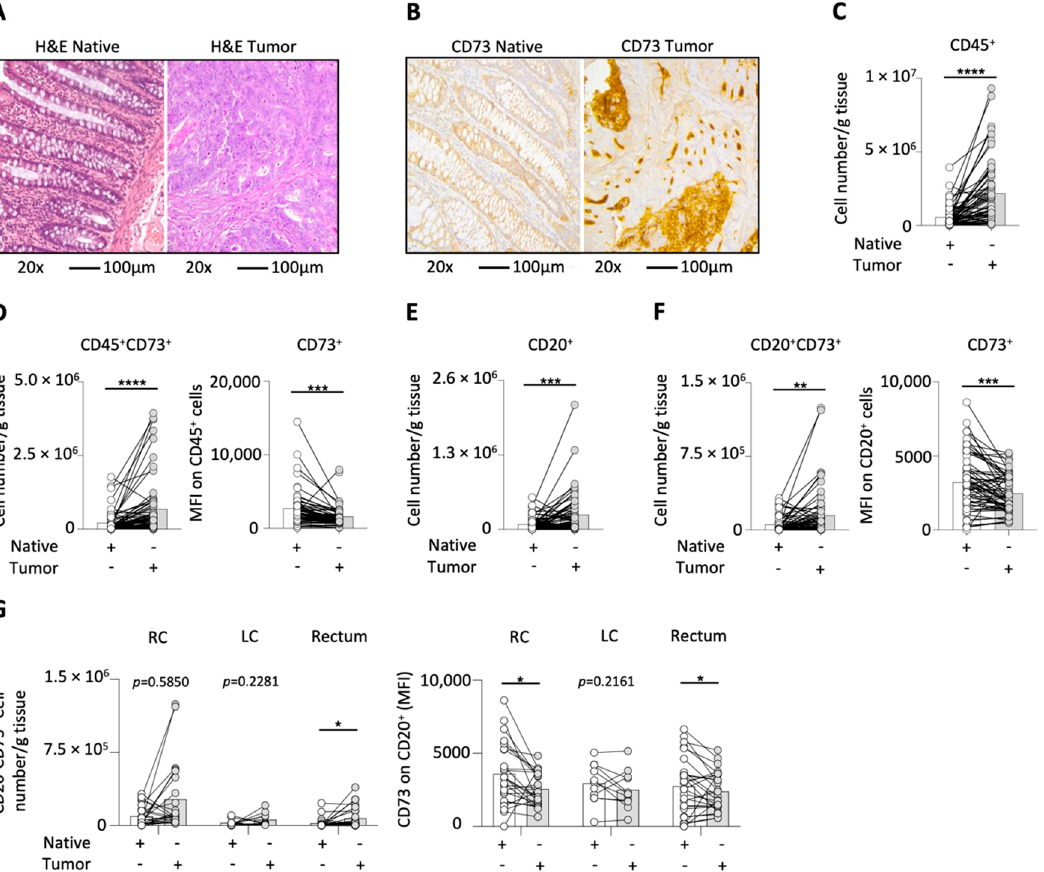
Figure 1. H&E ( A ) and IHC staining with CD73 ( B ) of native and tumor tissues in CRC patients; images are shown at 20× magnification; bars indicate 100 µm; CD45 + cell numbers were increased in tumors ( C ), CD45 + CD73 + leucocytes numbers and CD73 MFI on CD45 + cells ( D ), numbers of infiltrated CD20 + B-cells ( E ), cell count of CD20 + CD73 + B-cells and CD73 expression on B-cells ( F ), CD20 + CD73 + B-cell numbers and CD73 MFI on CD20 + B-cells in CRC tumors from different locations ( G ); **** = p < 0.0001; *** = p < 0.001; ** = p < 0.01; * = p < 0.05.